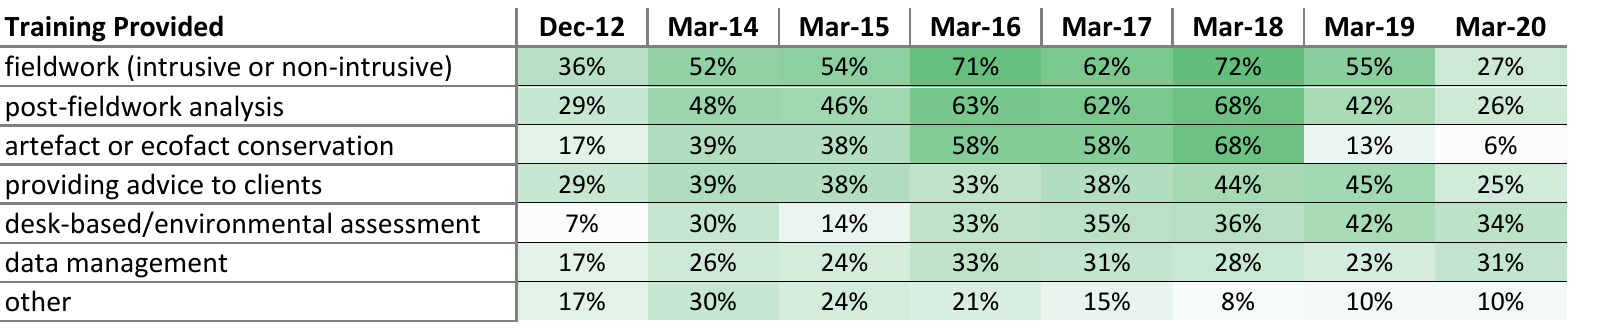
Table 232: Skills training provided from 2012 to 2020. Percentages calculated on total responses to all skills questions and not just those to this specific question. The assumption is made that those who did not respond did so because they had no need to train in those skills.